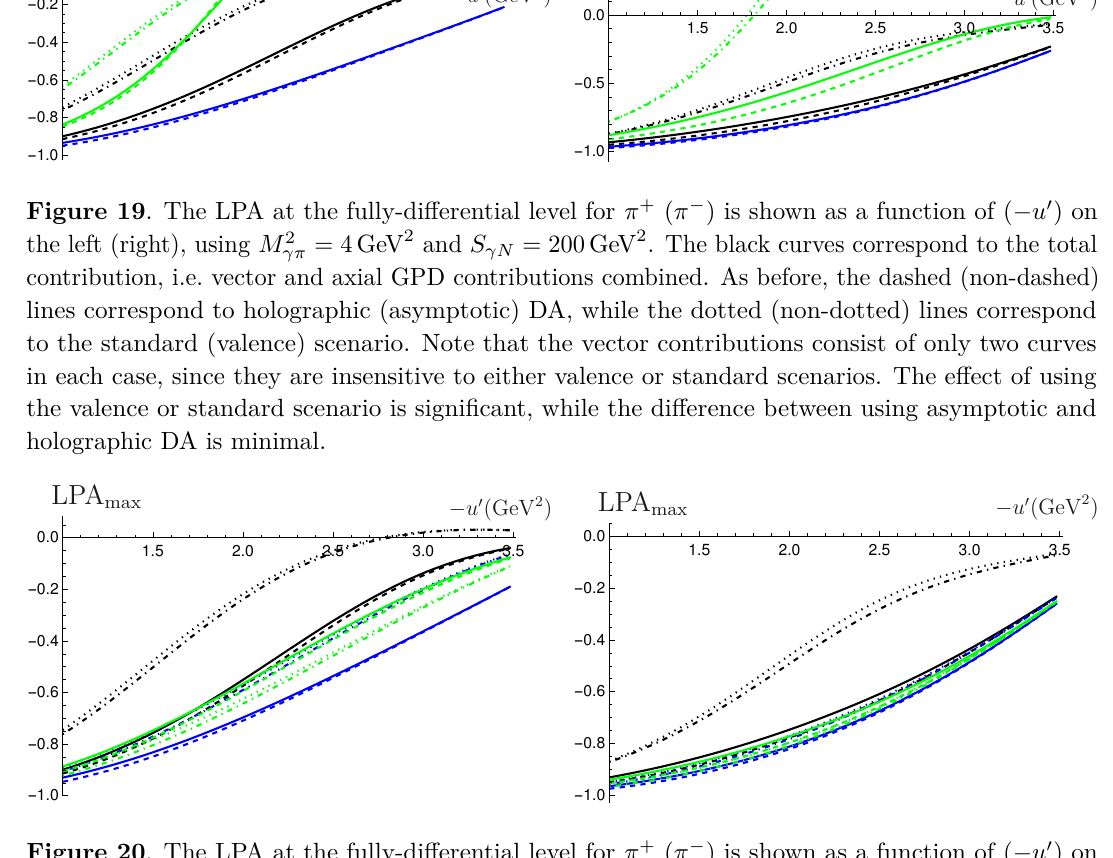
Figure 20 . The LPA at the fully-differential level for π + ( π − ) is shown as a function of ( − u 0 ) on the left (right), using M 2 = 4 GeV 2 and S = 200 GeV 2 . The blue and green curves correspond γN γπ to contributions from the u quark ( H and ˜ H ) and d quark ( H and ˜ H ) GPDs respectively. u u d d The black curves correspond to the total contribution. The dashed (non-dashed) lines correspond to holographic (asymptotic) DA, while the dotted (non-dotted) lines correspond to the standard (valence)